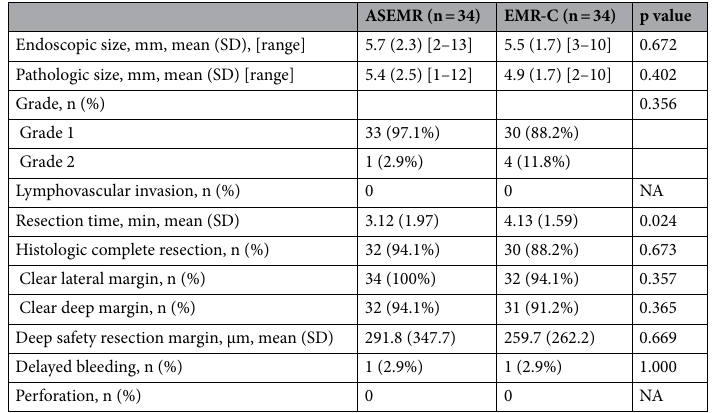
Table 2. Outcomes of established rectal NETs resected by ASEMR (n = 34) and EMR-C (n = 34). ASEMR anchored snare-tip endoscopic mucosal resection, EMR-C cap-assisted endoscopic mucosal resection, NET neuroendocrine tumor, SD standard deviation, NA not